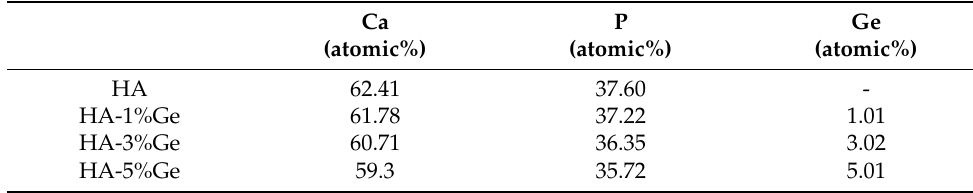
Table 1. EDX microanalysis of the HA-Ge composites.